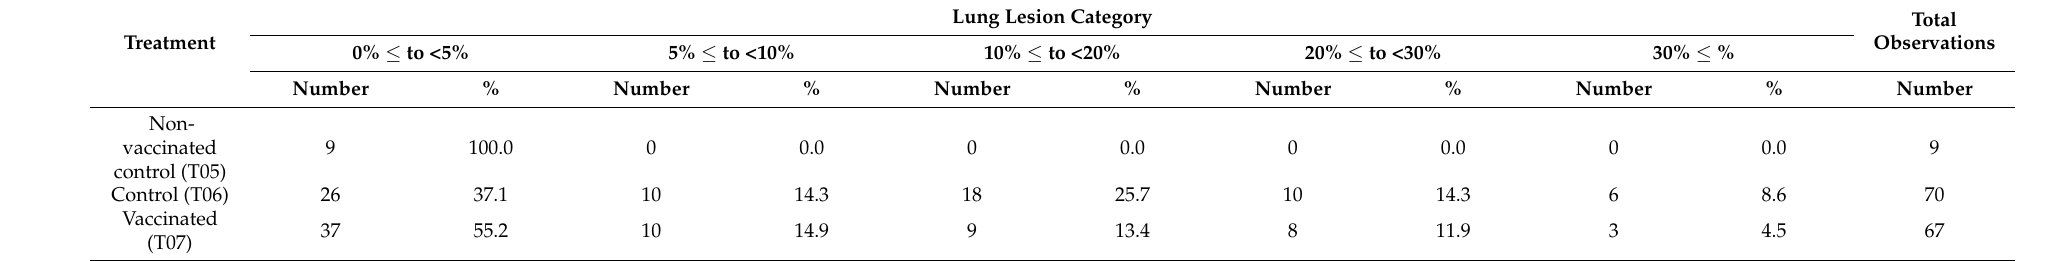
Table 5. Frequency distributions of total Mhyo -like macroscopic lung lesion categories by treatment.